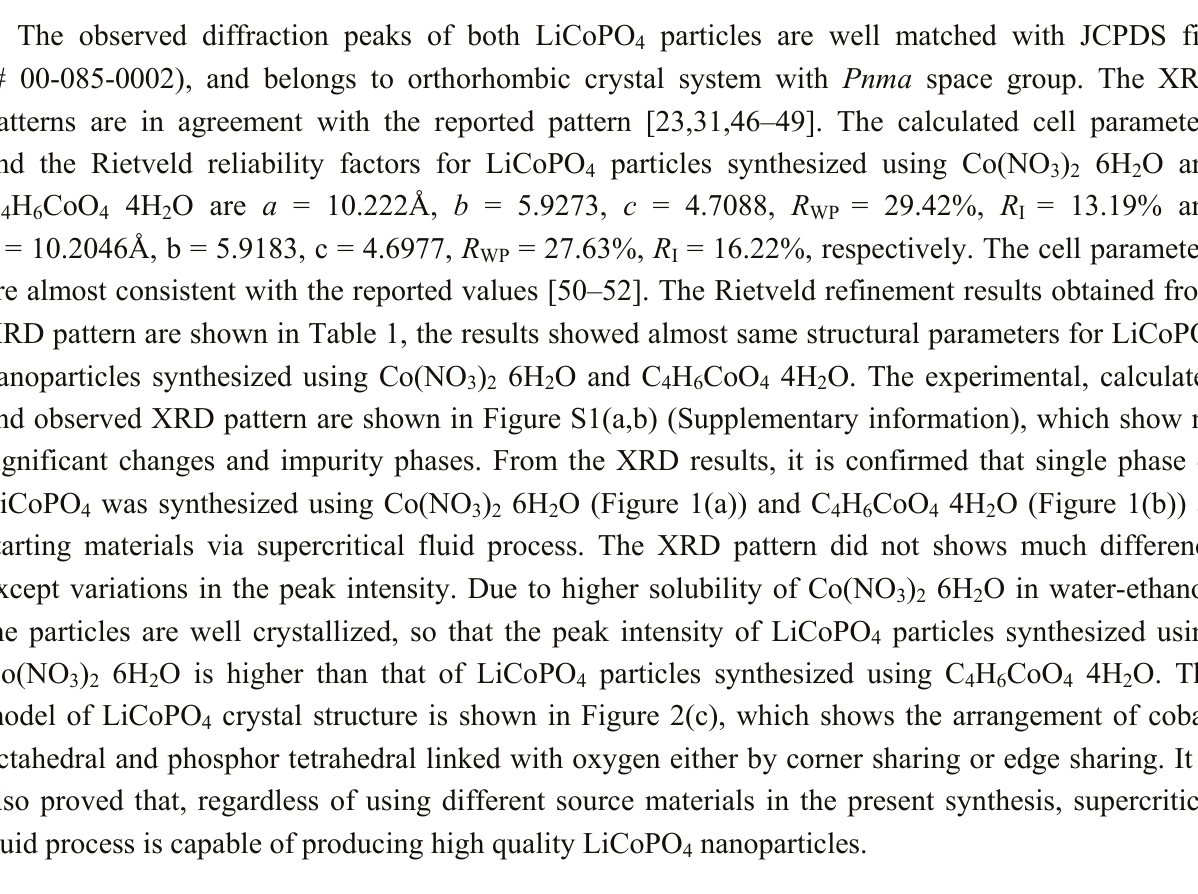
Table 1. Rietveld refinement results of XRD pattern of LiCoPO